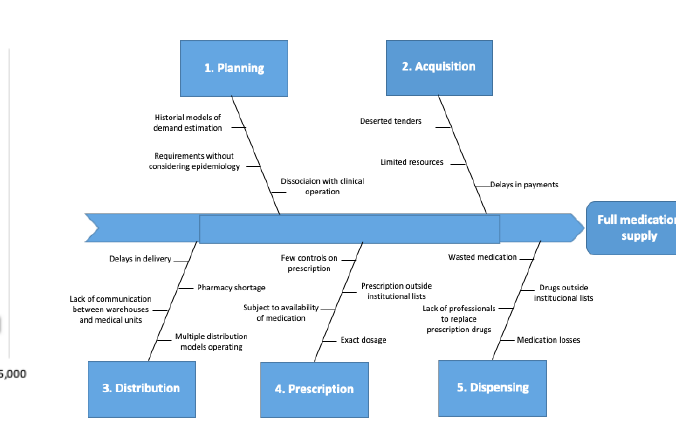
Figure 5. Problematic of the full drug